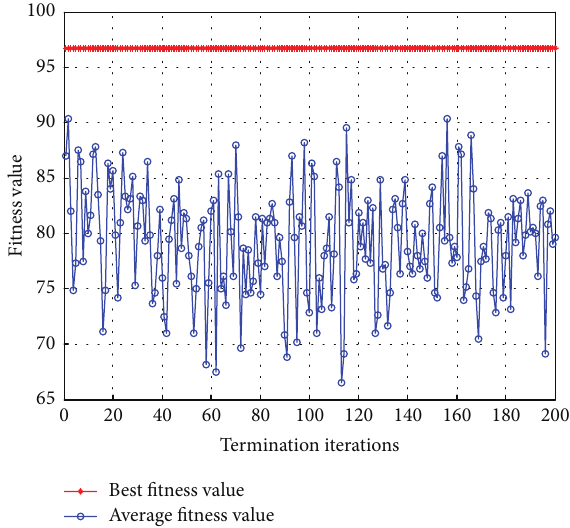
Figure 7: Optimal results of SVM via particle optimal method.